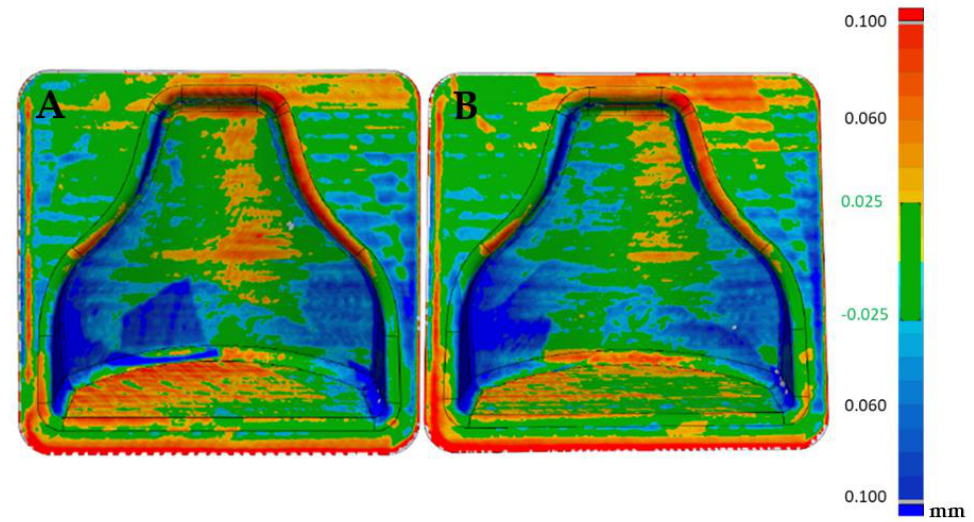
Figure 8. Comparison between the CAD model and first mold ( A ) and CAD model and second mold ( B ).